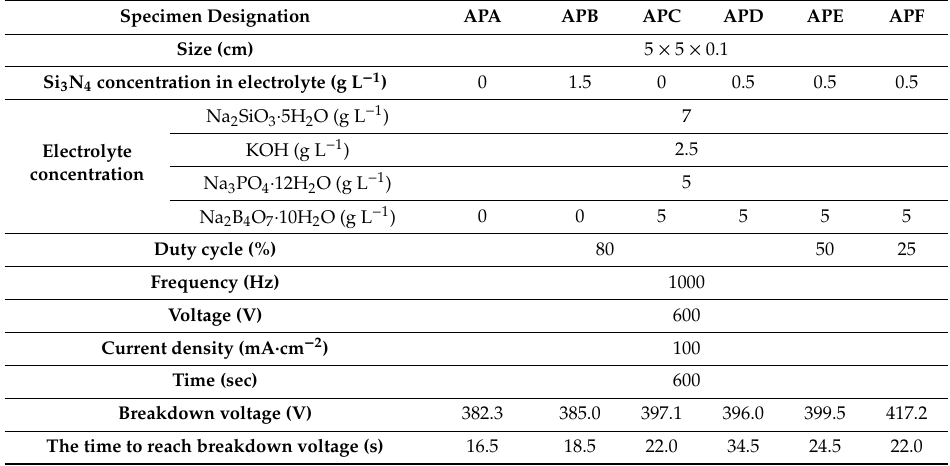
Table 1. Specimen designation and plasma electrolytic oxidation (PEO) process